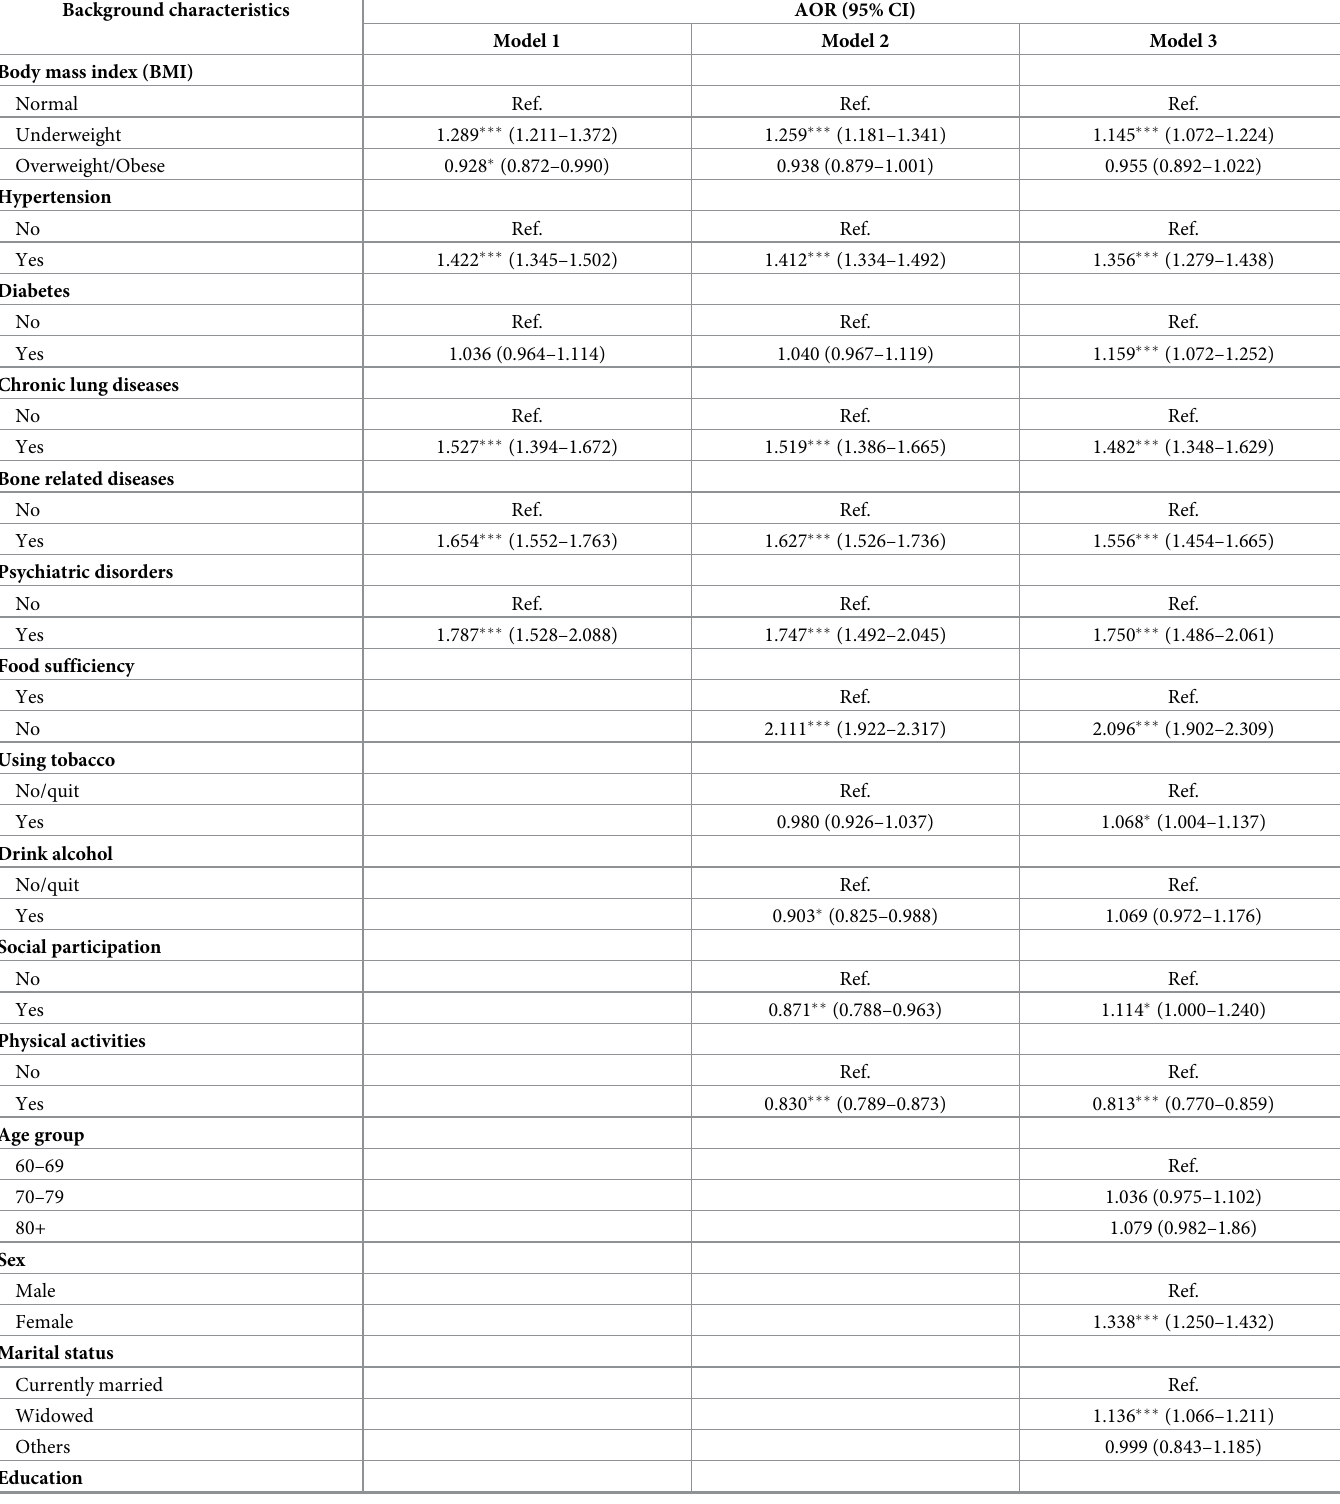
Table 3. Adjusted odds ratio (AOR) for the association of covariates with reporting insomnia